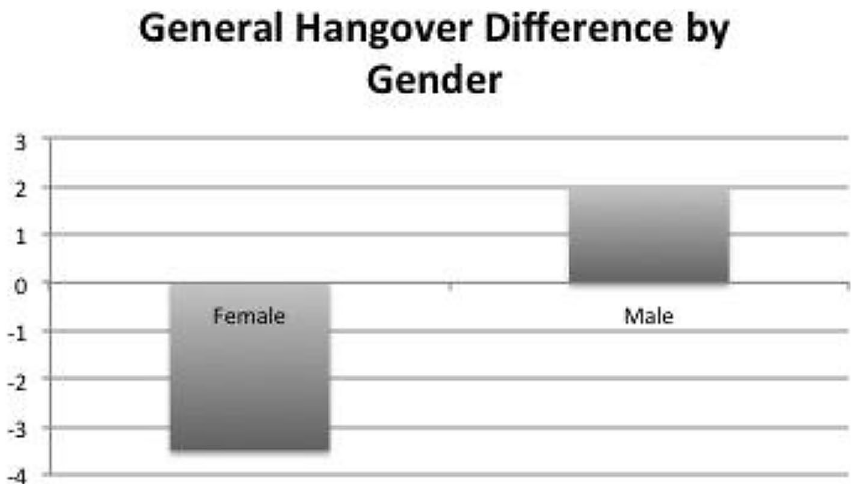
Figure 1. Significant difference found in the general distribution of total hangover difference scores (NAC— Placebo HSS) based on gender (Female − 3.5; Male 2) ( P = .04), specifically for nausea ( P = .05) and weakness ( P = .03). Suggestive of improved HSS NAC vs Placebo in individuals with high EtOH intake and/or high HSS.